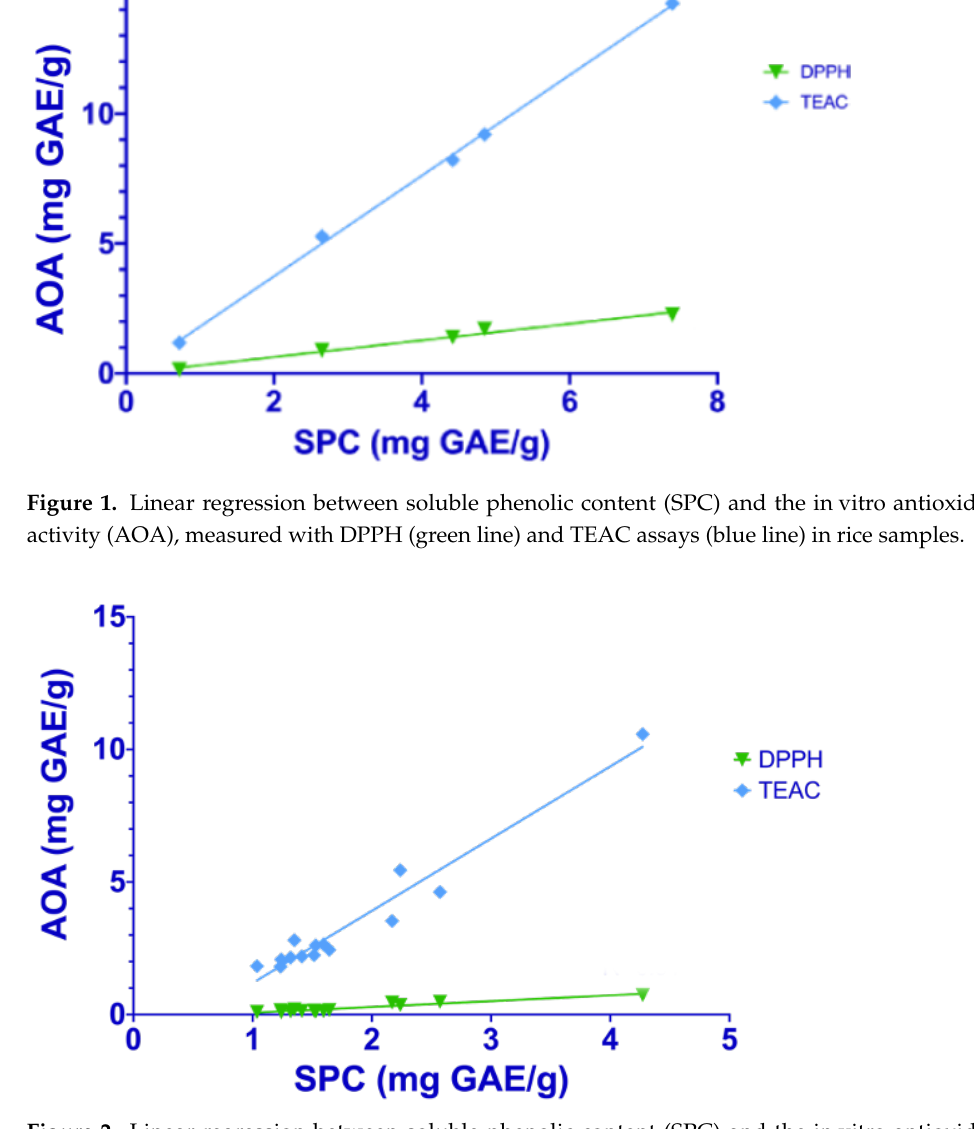
A positive linear correlation was found in rice samples between total polyphenol content and in vitro antioxidant activity evaluated with the DPPH (r = 0.989, p < 0.01) and TEAC (r = 0.995, p < 0.01) assays. Even for corn samples, a similar correlation was found